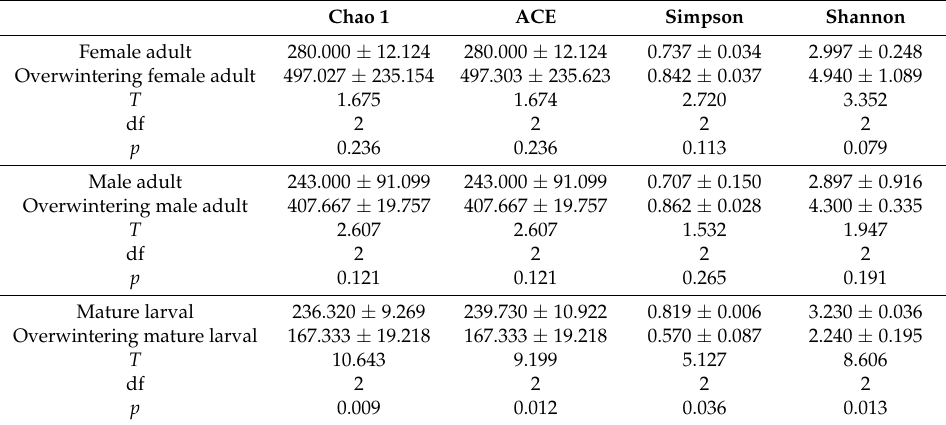
Figure 5. Venn diagram representing the distribution of the fungal OTUs in different generations of T. klimeschi. ( a ) Adult females vs. overwintering adult females; ( b ) adult males vs. overwintering adult males; ( c ) mature larvae vs. overwintering mature larvae. Table 3. Biodiversity index values of T. klimeschi in different generations.